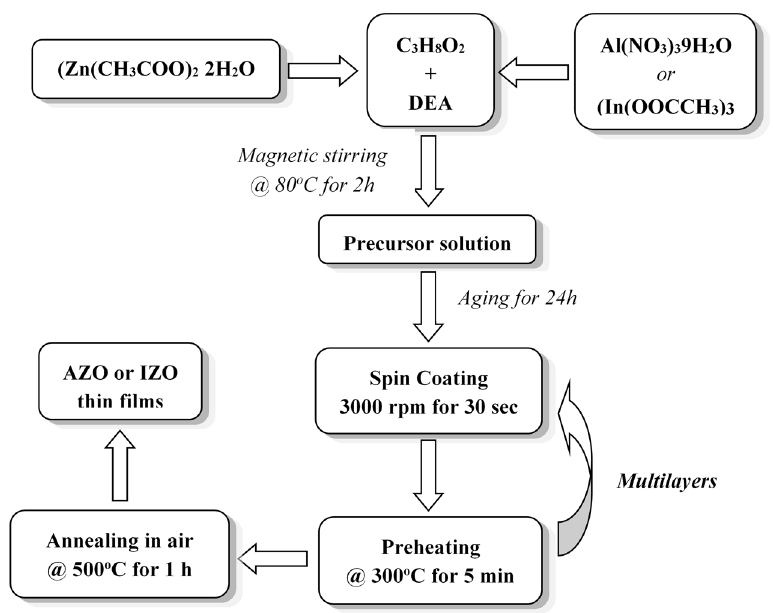
Figure 1. Flowchart of sol–gel spin coating deposition